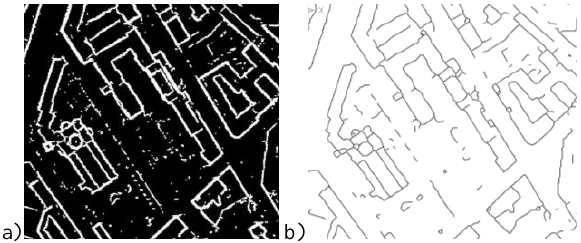
Figure 7. Building boundaries after bridging and dilation processes (a) and after smoothing process (b).